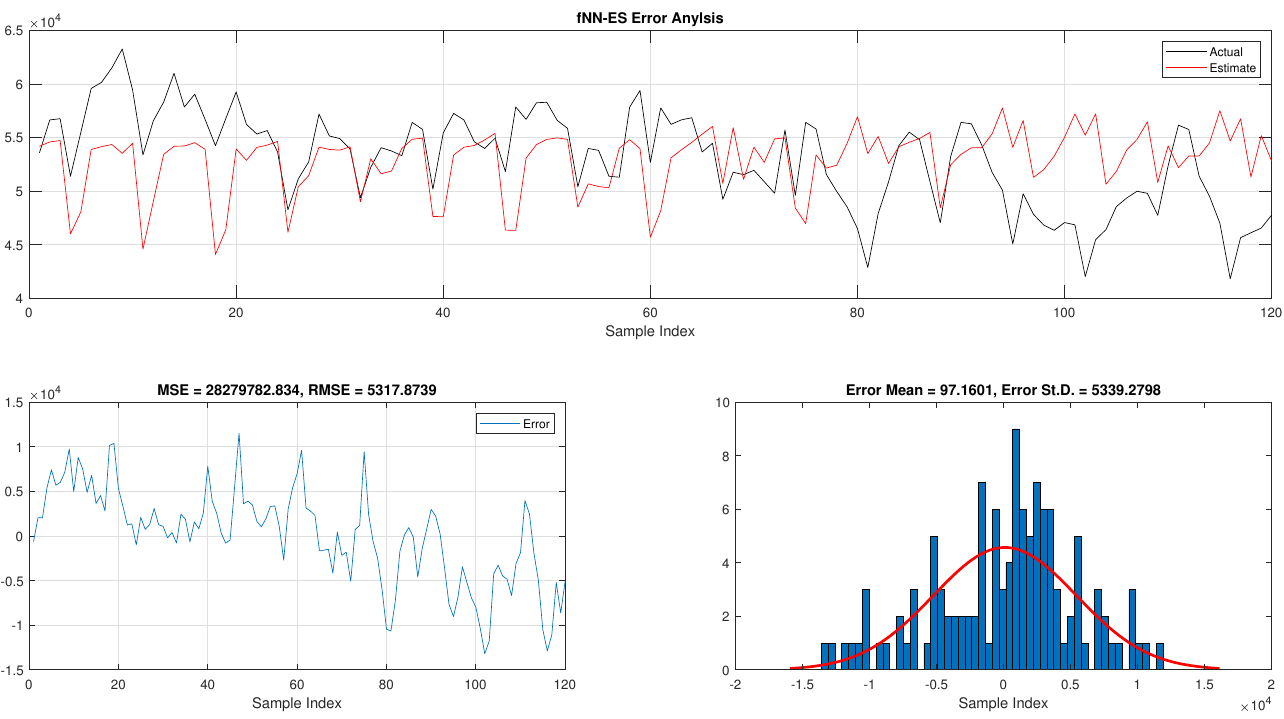
Figure 19. Error analysis of the total daily load consumption with fNN-ES best